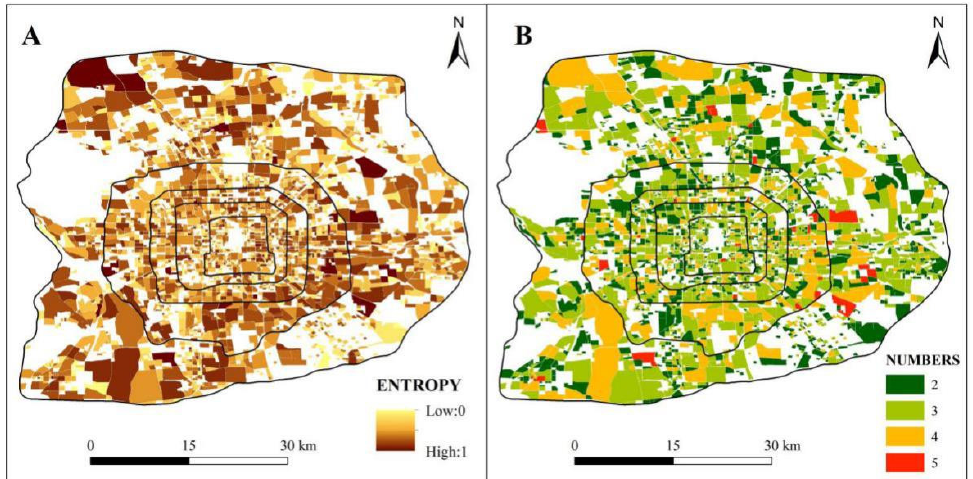
Figure 6. Spatial distribution of the entropy index ( A ) and type number index ( B ).